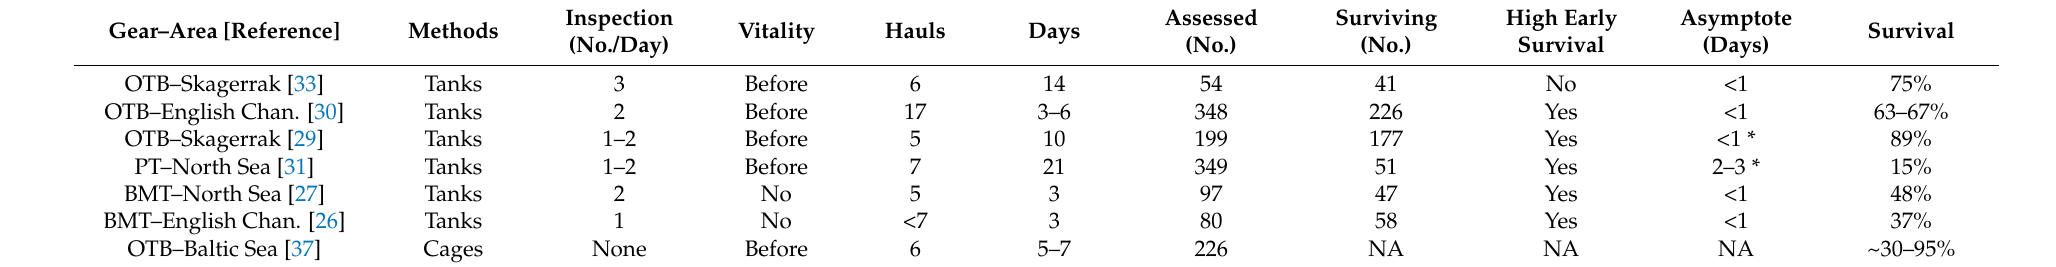
Table 1. Overview of discard DSSs on plaice captured during the winter season (1 November–30 April), including information on gear type (bottom otter trawl, OTB; pulse trawl, PT; beam trawl, BMT); fishing area; methods (land-based tanks (tanks) or seabed cages (cages)); inspections of the captative fish (no/day); vitality assessments conducted (before indicates before capitative observations); and number of hauls. Days indicate the length of the captive observation period, and the number of assessed fish (start of captive observation period) and number of surviving fish (start of captive observation period) are also represented. High early survival indicates whether survival rates were the highest in the first 3 days, asymptote days indicate the number of days with 0 mortalities prior to the end of observation periods (asymptote) and if the decline in mortality over the last 0 days of observation was below 5 percentage points (*), and finally, the table depicts survival at the end of the observation